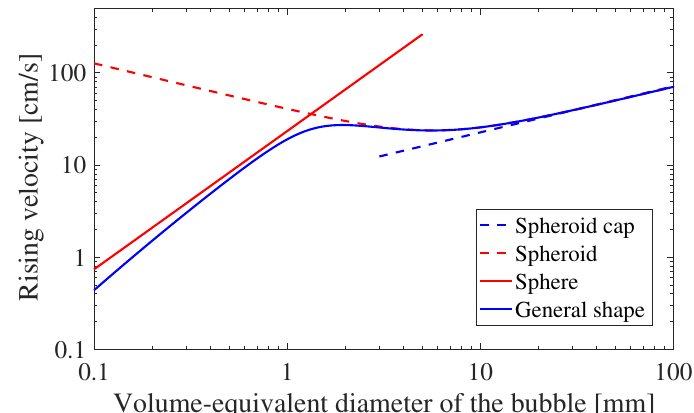
Figure 5. The rising velocities for bubbles with different